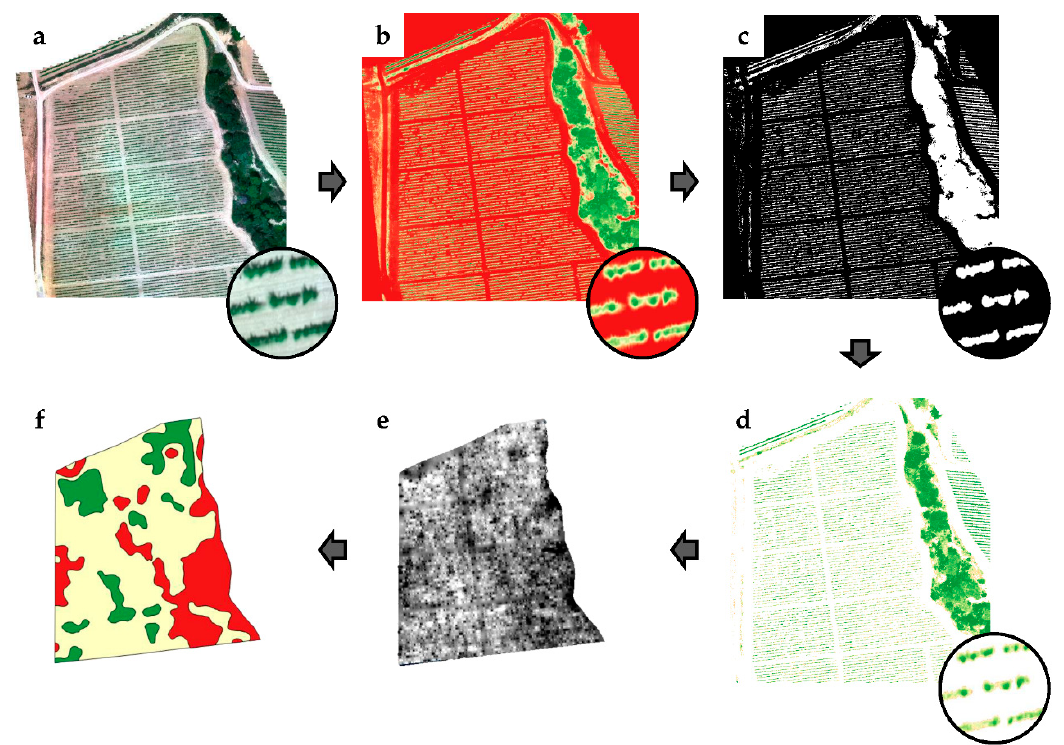
Figure 3. Analysis of workflow to obtain clustered vigour maps: ( a ) radiometrically calibrated multiband image, ( b ) NDVI image, ( c ) binary mask of vineyard-only pixels, ( d ) NDVI vineyard-only pixels, ( e ) continuous NDVI map, ( f ) clustered vigour map (red: low vigour, yellow: medium vigour, green: high vigour).